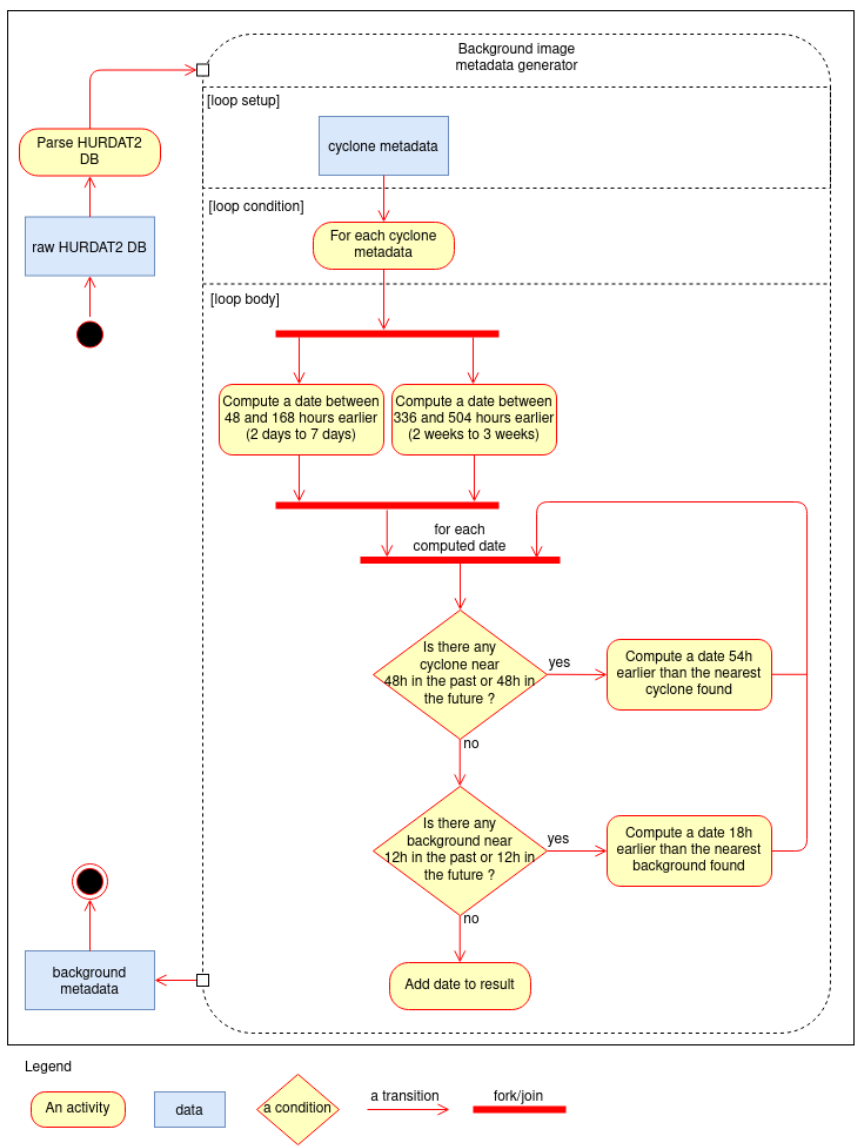
Figure 2. UML2 activity diagram of the background image metadata